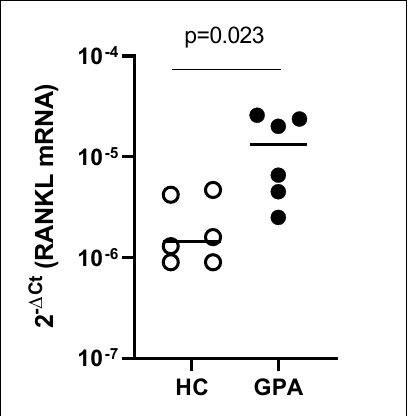
Figure 1. Elevated RANKL mRNA (NM_003701.4) expression by PBMC derived from patients with GPA compared to healthy controls (HC, n = 6 each). The 18S rRNA gene (NR_003286.3) was used for normalization. Primer sequences are available upon request. 5. In GPA or PR3-AAV, Granulomatous Inflammation is a Prerequisite for the Devel- opment of Local Autoimmune Responses